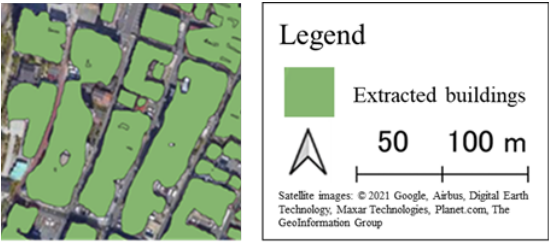
Figure 6. Example of region where the number of buildings is large